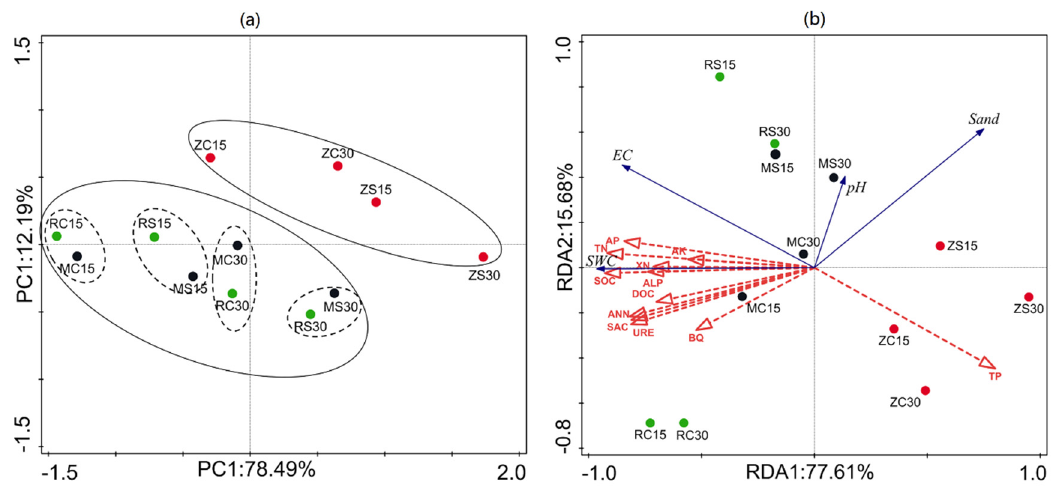
Figure 5. ( a ) Principal component analysis (PCA) of soil physical chemical and biological properties; ( b ) ordination triplot (RDA) of environmental variables, soil nutrients, and enzyme activities.